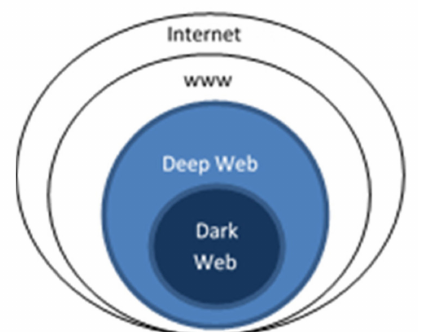
Figure 1. The relationship between the Internet, Deep Web and Dark